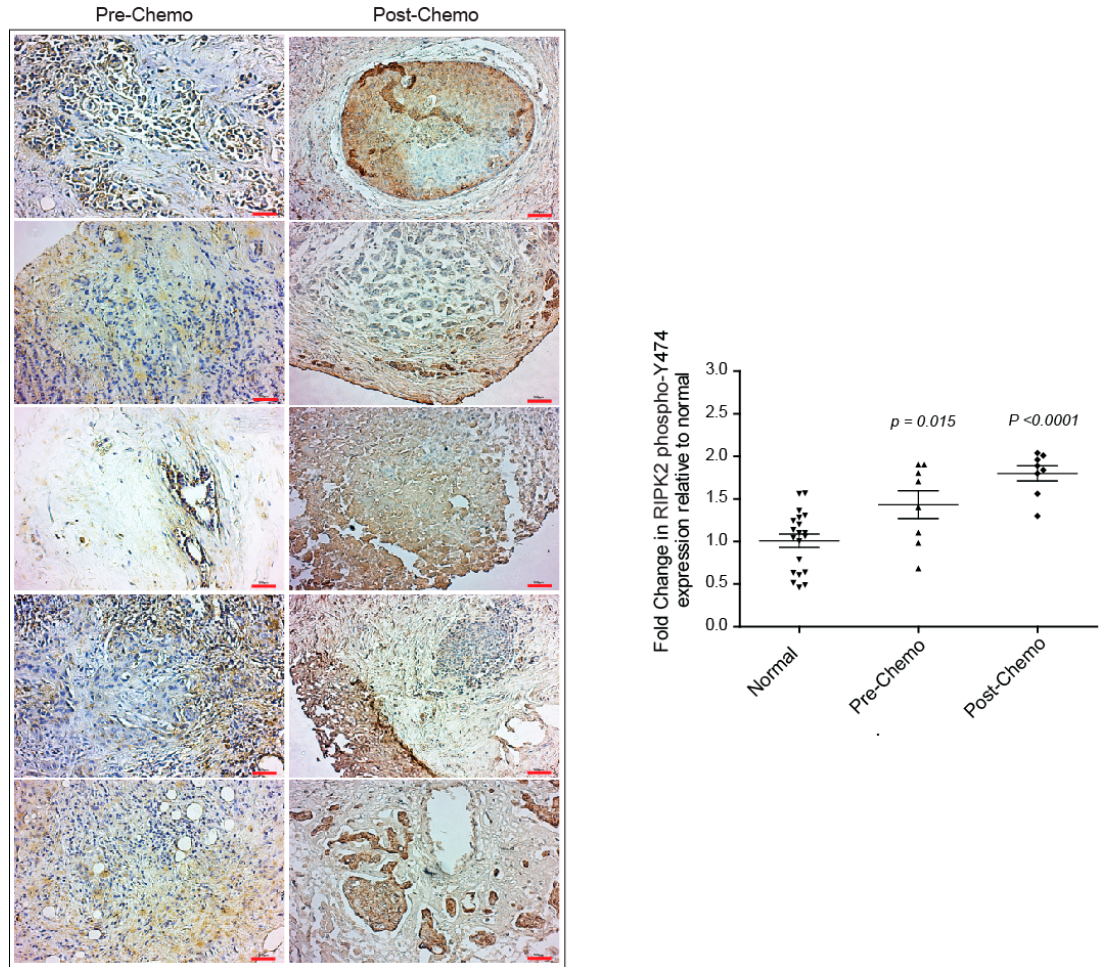
Figure 4. Immunohistochemical staining using the RIPK2 phospho-Y474 antibody in IBC breast tissue pre- and post-chemotherapy as indicated. Red scale bar: 50 µm. DAB staining was quantified using ImageJ software and normalized to normal non-neoplastic breast tissue. A total of eight IBC patient tissues pre- and post-chemotherapy were quantified. p -values represent the difference between normal and pre-chemo and post-chemo, respectively.